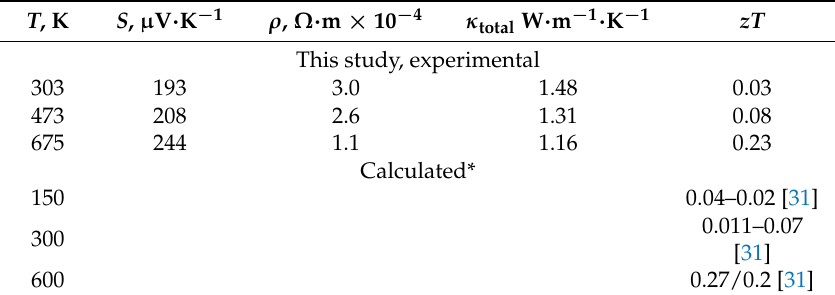
Table 3. Selected thermoelectric parameters of the NaZnSb compound.